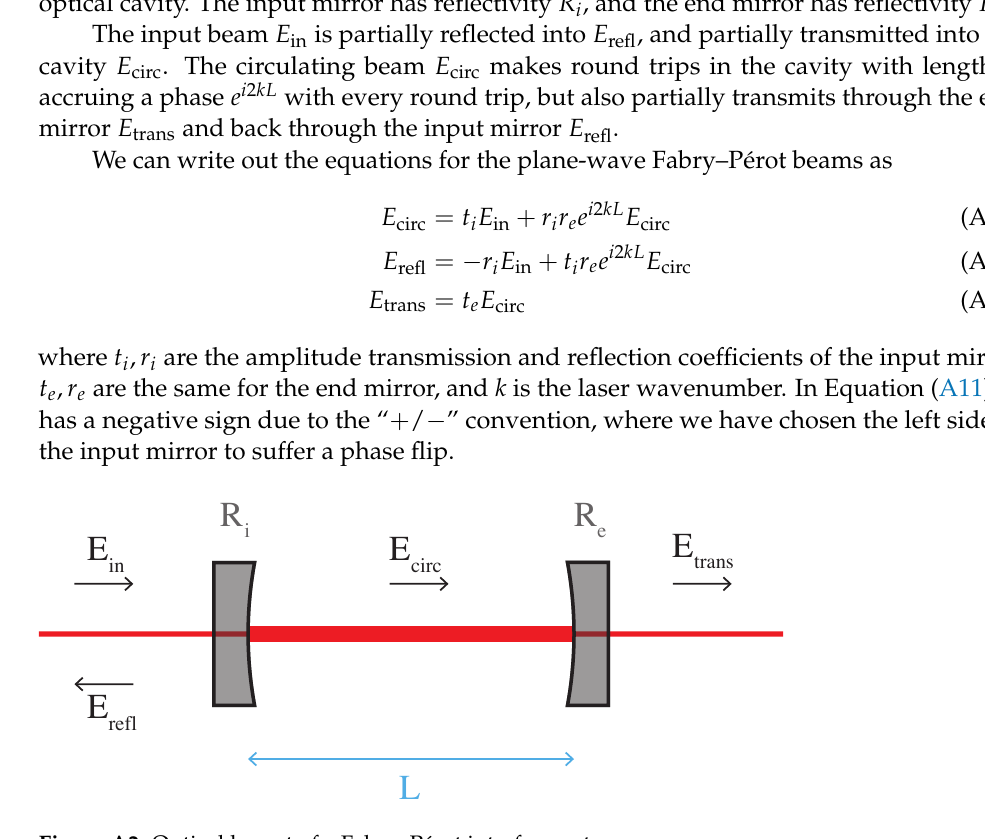
Figure A2. Optical layout of a Fabry–Pérot